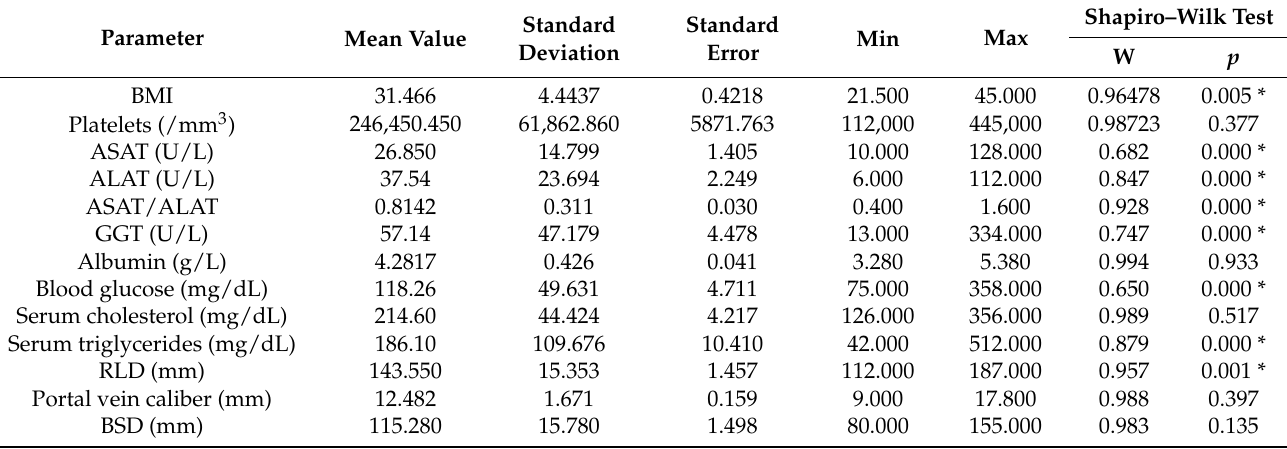
Table 1. General characterization of the parameters analyzed.